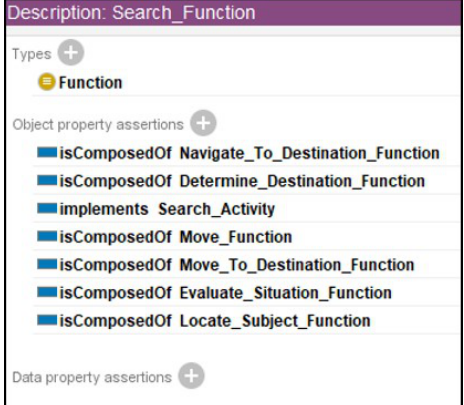
Figure 14. The definition of the individual describing a Search